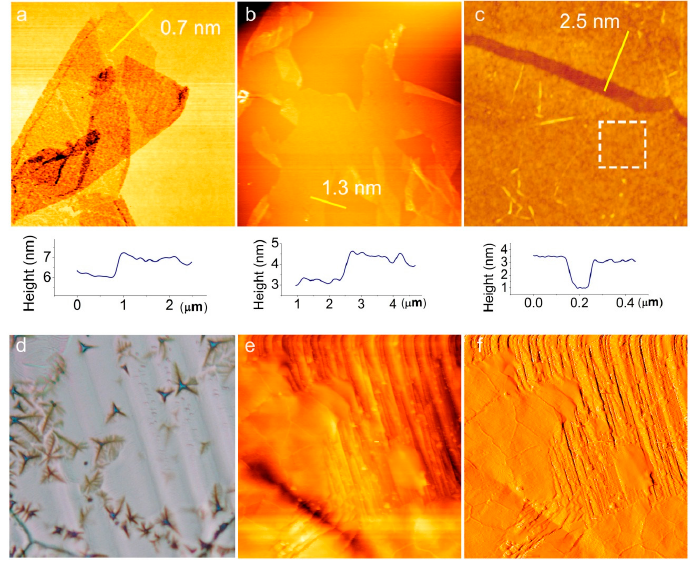
Figure 3. AFM morphologies of as-transferred h-BN on SiO 2 with thicknesses of 0.78 nm ( a ), 1.3 nm ( b ) and 2.5 nm ( c ), respectively, corresponding to one- to two-layered, three- to four-layered and six- to seven-layered h-BN. Inset of each image shows the height profile of the cross-sections. The sizes of Figure (a–c) are 10 µm × 10 µm, 30 µm × 30 µm= and 1.5 µm × 1.5 µm. ( d ) Optical image of h-BN bulk. ( e , f ) Topography and corresponding current sensing AFM image of h-BN on Ni foil. Size: 20 µm × 20 µm. Thickness: ~20 nm.